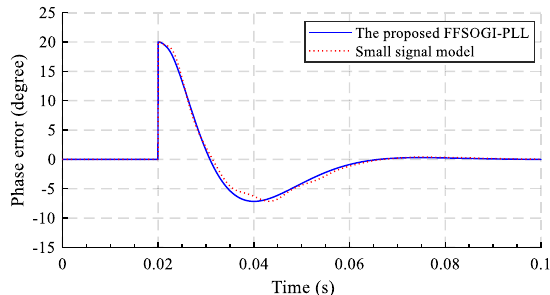
Fig. 3 Performance comparison between the actual response of the proposed FFSOGI-PLL and its small-signal model with a 20° phase jump at 0.02 s